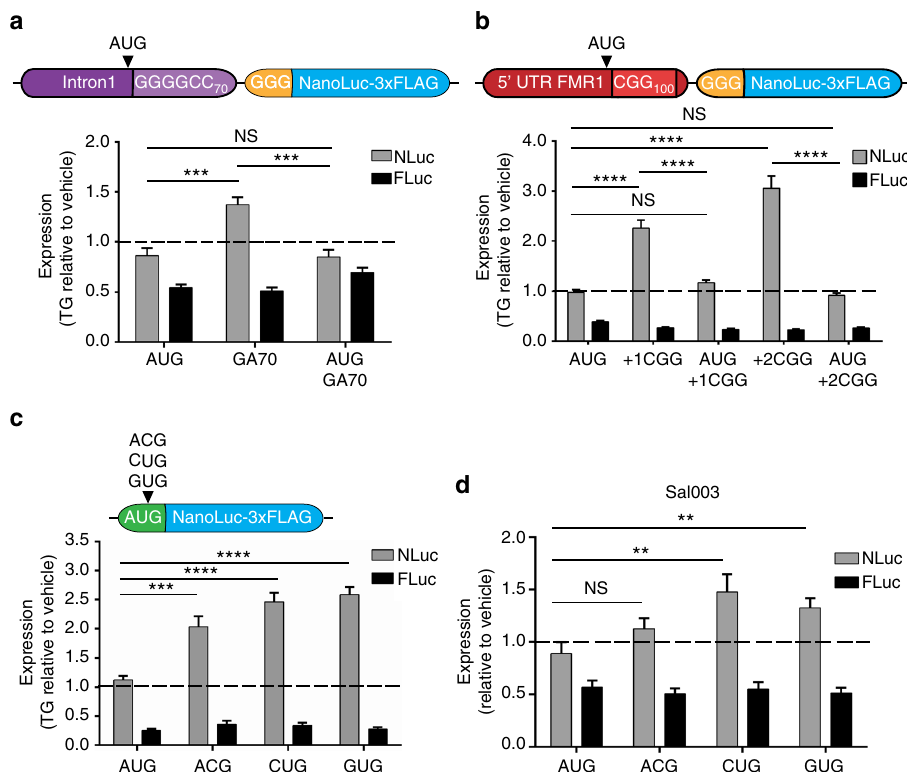
Fig. 5 Near-cognate codons are suf fi cient to allow for stress-induced translation. a Top: schematic of C9RAN reporter with AUG codon inserted upstream of repeat. Bottom: expression of control, C9RAN NLuc, and AUG-driven C9 reporters and co-transfected FLuc in HEK293 cells treated with 2 μ M TG, n = 6 – 9. b Top: schematic of CGG RAN reporter with a near-cognate codon mutated to AUG. Bottom: expression of control, CGG RAN NLuc, and AUG-driven CGG reporters and co-transfected FLuc in HEK293T cells treated with 2 μ M TG, n = 9. c Top: schematic showing location of near-cognate codon substitutions made in AUG-NLuc. Bottom: expression of control and near-cognate codon NLuc reporters and co-transfected FLuc in HEK293T cells treated with 2 μ M TG, n = 9. d Expression of control and near-cognate codon NLuc reporters and co-transfected FLuc in HEK293T cells treated with 20 μ M Sal003 for 5 h, n = 12. Graphs represent mean ± SEM. Two-tailed Student ’ s t test with Bonferroni and Welch ’ s correction, ∗∗ p < 0.01; ∗∗∗ p < 0.001; ∗∗∗∗ p <